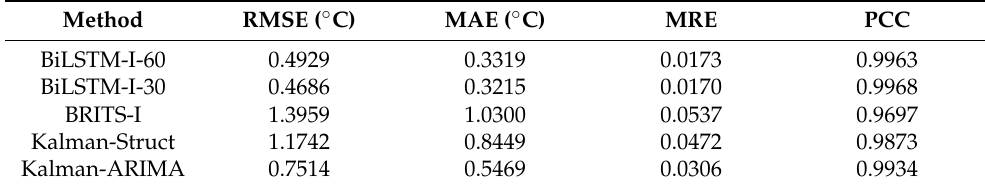
Figure 3. Comparison the imputation results of different methods with the observation data. Data for three days were randomly selected. Table 3. Statistical table of the results of the time series imputation